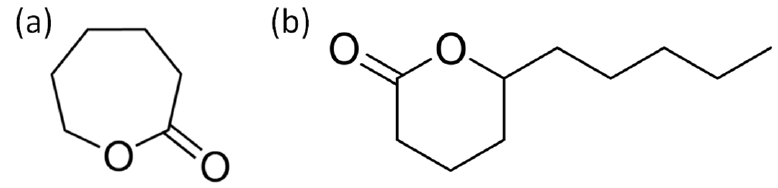
Figure 1. Chemical structure of ( a ) ε -caprolactone and ( b ) δ -decalactone.